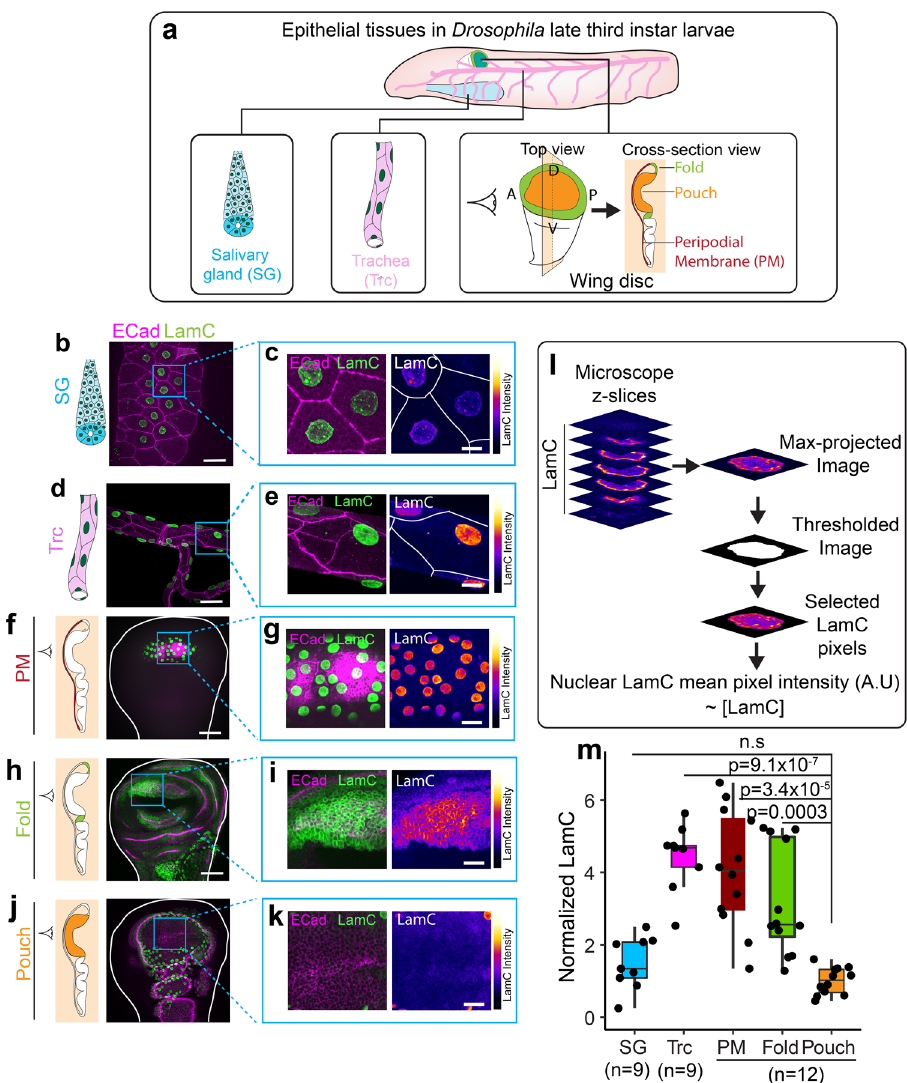
Fig. 1 LamC levels vary across different epithelial tissues. a Schematic showing different epithelial tissues in Drosophila . b LamC in salivary glands. Image of trachea showing E-Cad (magenta) and LamC (green). c Enlarged image of the region marked by the blue ROI in ( b ). Left panel shows the merge of E-Cad and LamC. Right panel shows the color-coded LamC intensity. Solid white lines represent cell boundaries. d LamC in trachea. Image of salivary gland showing E-Cad (magenta) and LamC (green). e Enlarged image of the region marked by the blue ROI in ( e ). Left panel shows the merge of E-Cad and LamC. Right panel shows the color-coded LamC intensity. Solid white lines represent cell boundaries. f LamC in trachea. Image of PM showing E-Cad (magenta) and LamC (green). g Enlarged image of the region marked by the blue ROI in ( f ). Left panel shows the merge of E-Cad and LamC. Right panel shows the color-coded LamC intensity. h LamC in the fold. Image of fold showing E-Cad (magenta) and LamC (green). i Enlarged image of the region marked by the blue ROI in ( h ). Left panel shows the merge of E-Cad and LamC. Right panel shows the color-coded LamC intensity. j LamC in the pouch. Image of pouch showing E-Cad (magenta) and LamC (green). k Enlarged image of the region marked by the blue ROI in ( j ). Left panel shows the merge of E-Cad and LamC. Right panel shows the color-coded LamC intensity. l Schematic showing the estimation of LamC levels in the nucleus of epithelial tissues. m Box-plot showing the normalized levels of LamC in the epithelial tissues. Normalization is performed with respect to the levels in the pouch. The sample number, n represents the number of biologically independent tissue samples. One-way ANOVA was performed to estimate p values. The p values are shown in comparison to LamC levels in the pouch. P v alues are indicated in the respective plots and n.s represents the differences are not signi fi cant. Scale bar in overview images ( b , d , f , h , j ), 25 µ m. Scale bar in enlarged images, 15 µ m. In the box-plot, horizontal line represents the median of the data, lower and upper bounds of the box represent the 25th and 75th percentile of data, and the whiskers represent the minimum and maximum of the data. The scattered point on the box represents the actual data